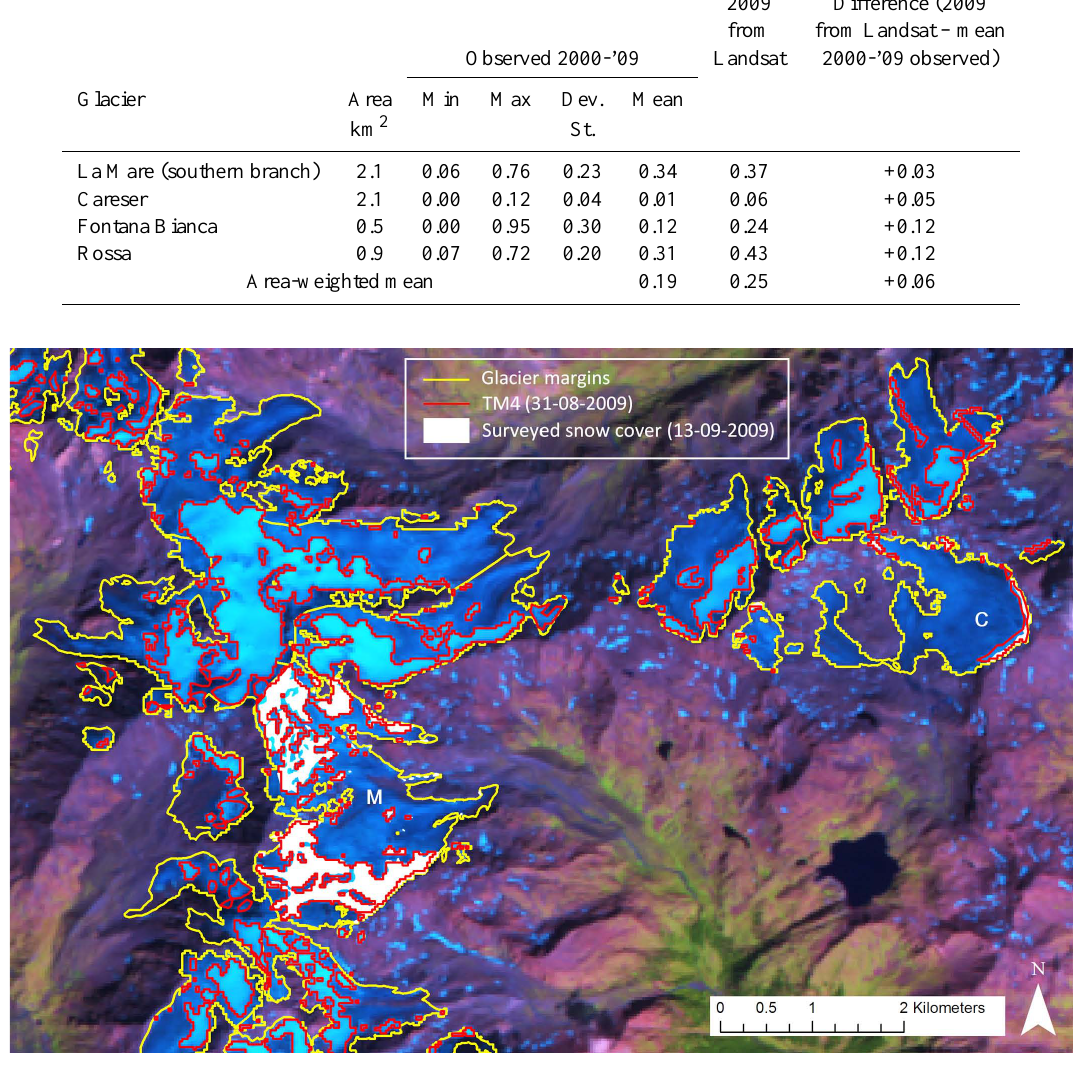
Fig. 5. Comparison of snow cover mapping from ground surveys (white areas) and from Landsat (TM4, red line) at the end of the 2009 ablation season on La Mare (M) and Careser (C) glaciers. The background image is a composite with Landsat bands TM 5, 4, and 3 as